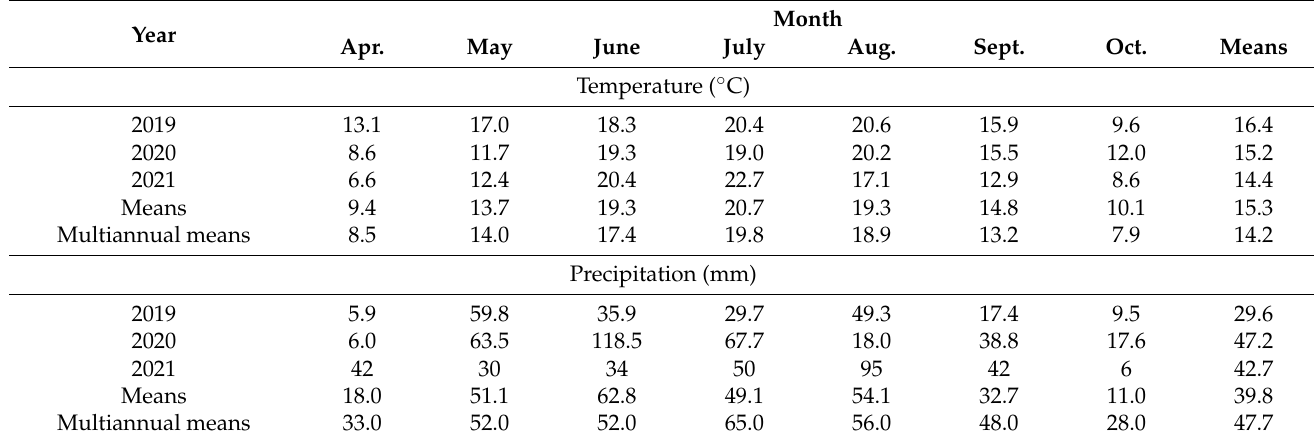
Table 2. Average air temperature and sum of atmospheric precipitation in consecutive months of the growing